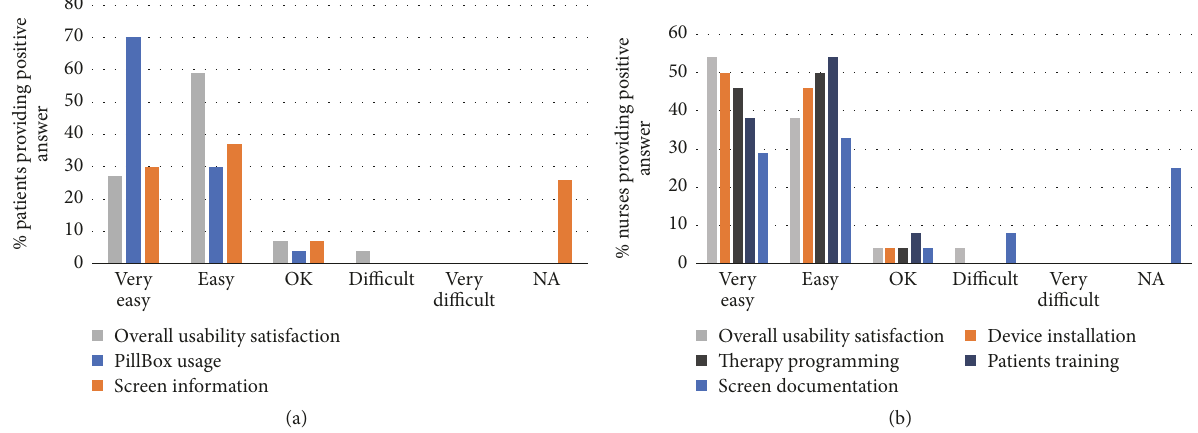
Figure 7: Patients (a) and medical staff (b) report ease of care and usability of PCoA Acute. Data was obtained from the questionnaires.